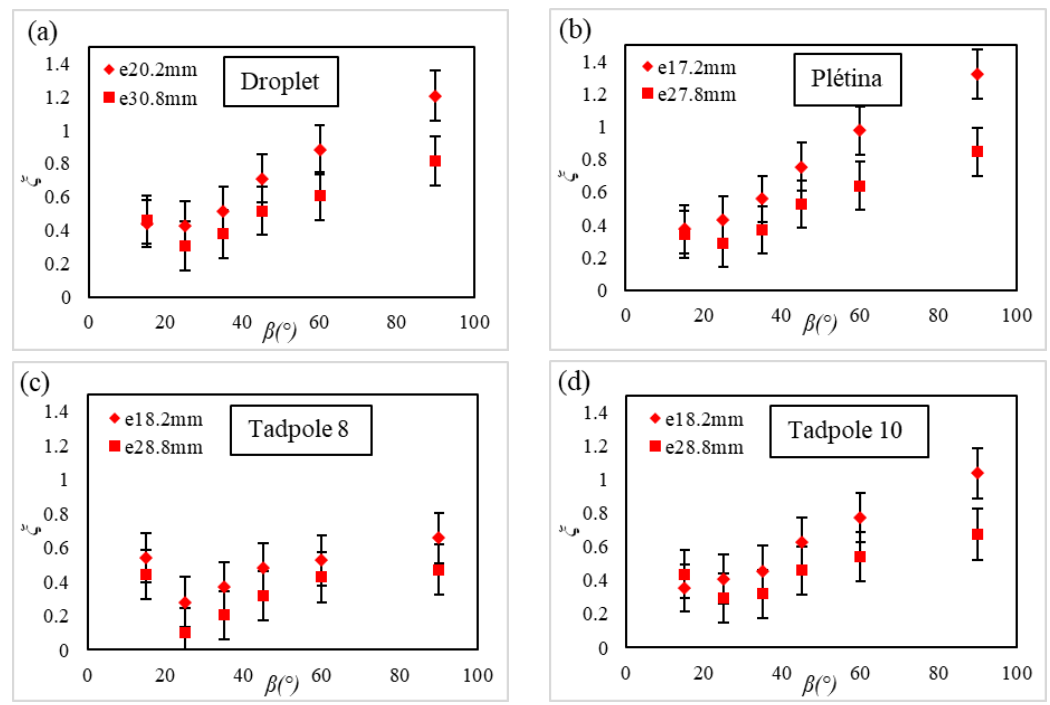
Figure 7. Comparison of measured head loss coefficients ξ for the four bar shapes (( a ) for Droplet, ( b ) for Plétina, ( c ) for Tadpole 8, ( d ) for Tadpole 10) and the two bar spacings for each one, as a function of the angle of inclination β